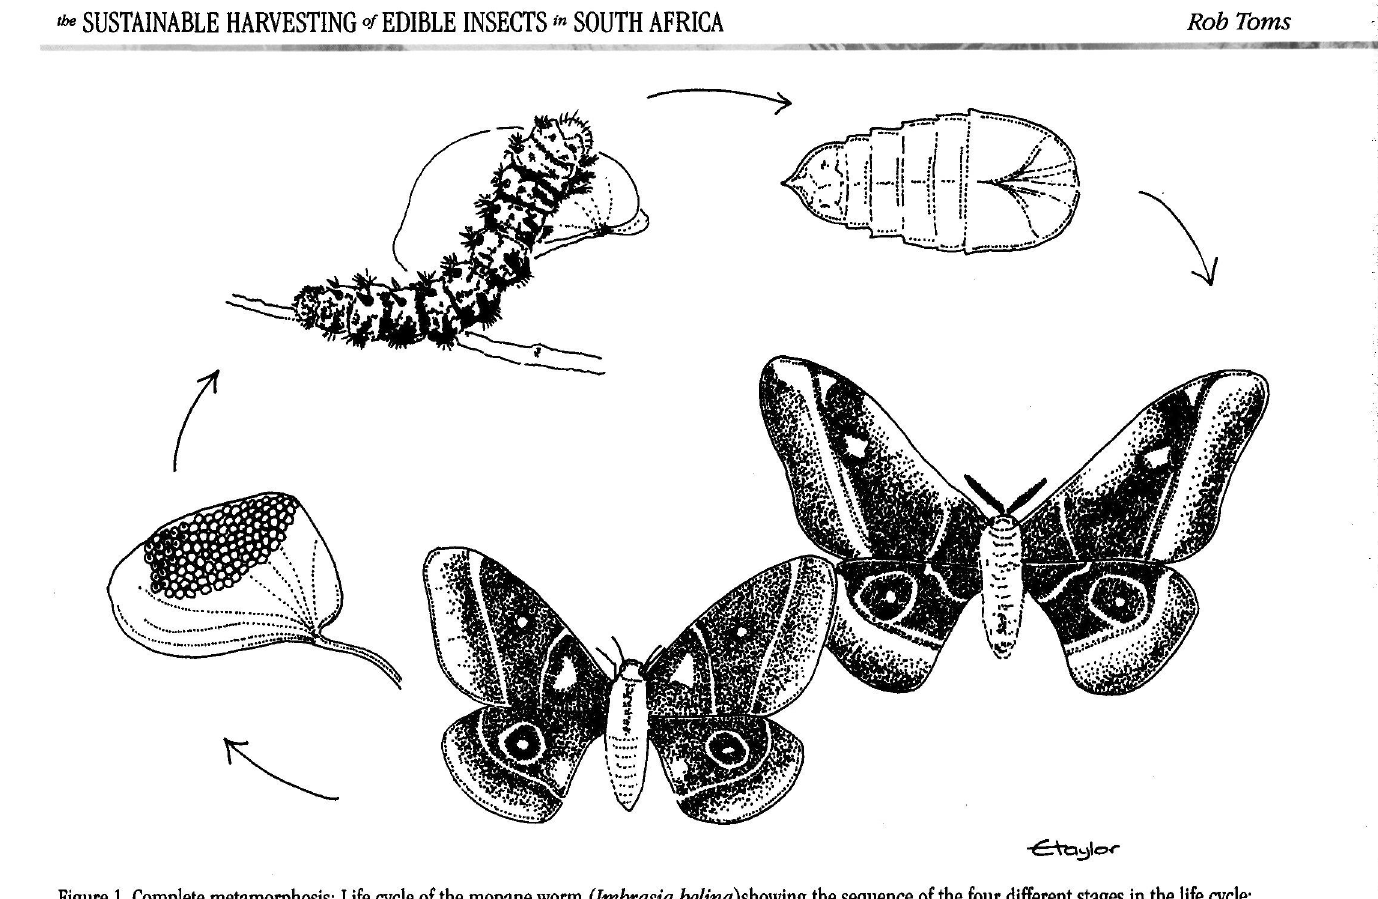
Figure 1. Complete metamorphosis: Life cycle of the mopane worm Qmbrasia M'w)showing the sequence of the four different stages in the life cycle: eggs, larva (caterpillar), pupa and the adult male and female moths. If any stage in the life cycle is eliminated in a region the life cycle will be broken and a local extinction will occur (Artwork: E. Taylor).